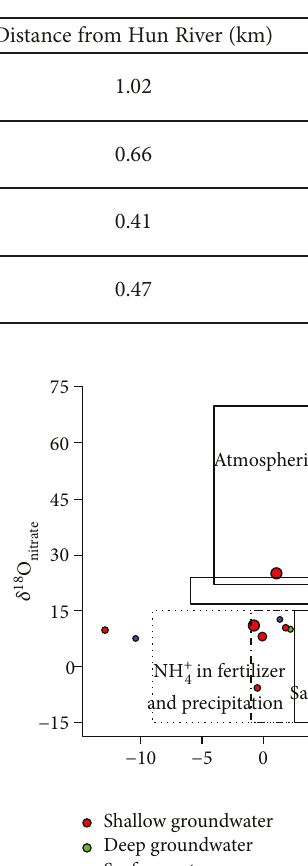
Table 6: The recharge ratios of the Hun River to the